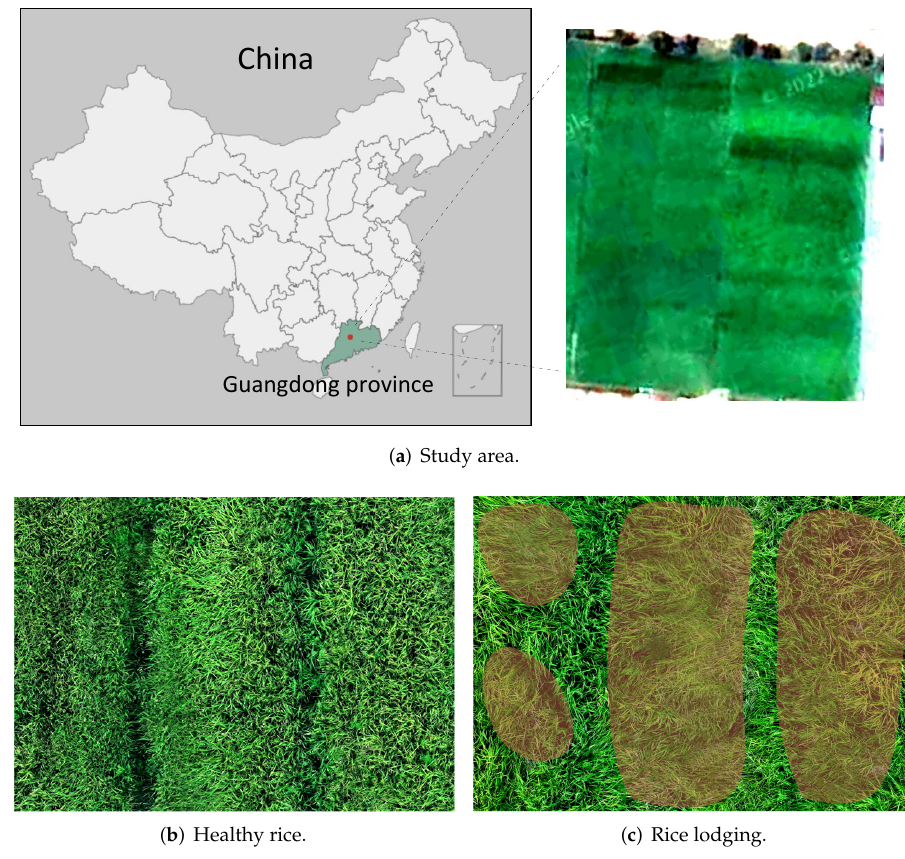
Figure 2. Dataset overview. The lodging areas in the rice field are highlighted in